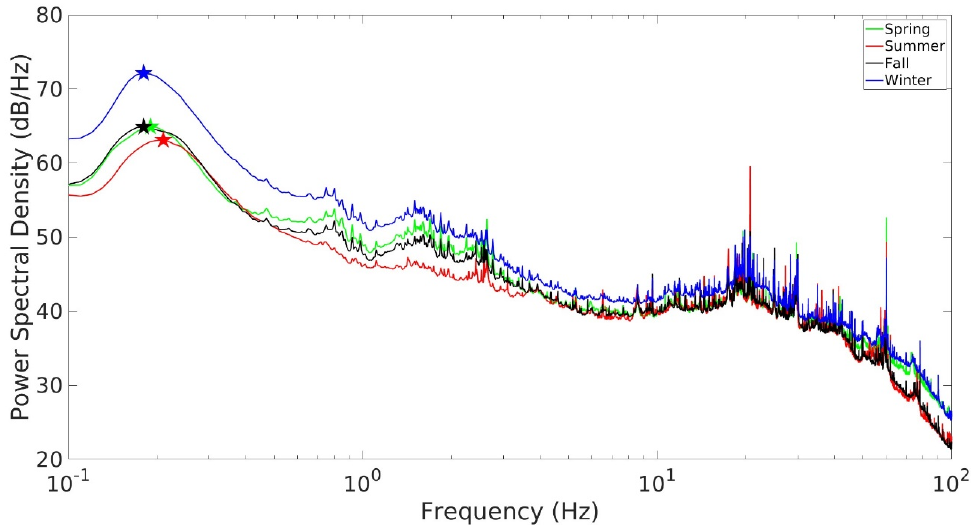
Figure 8. Average PSD with strong microbarom detection per season (Spring: March–May; Summer: June–August; Fall: September–November; Winter: December–February), with the peak microbarom amplitude marked with star markers.